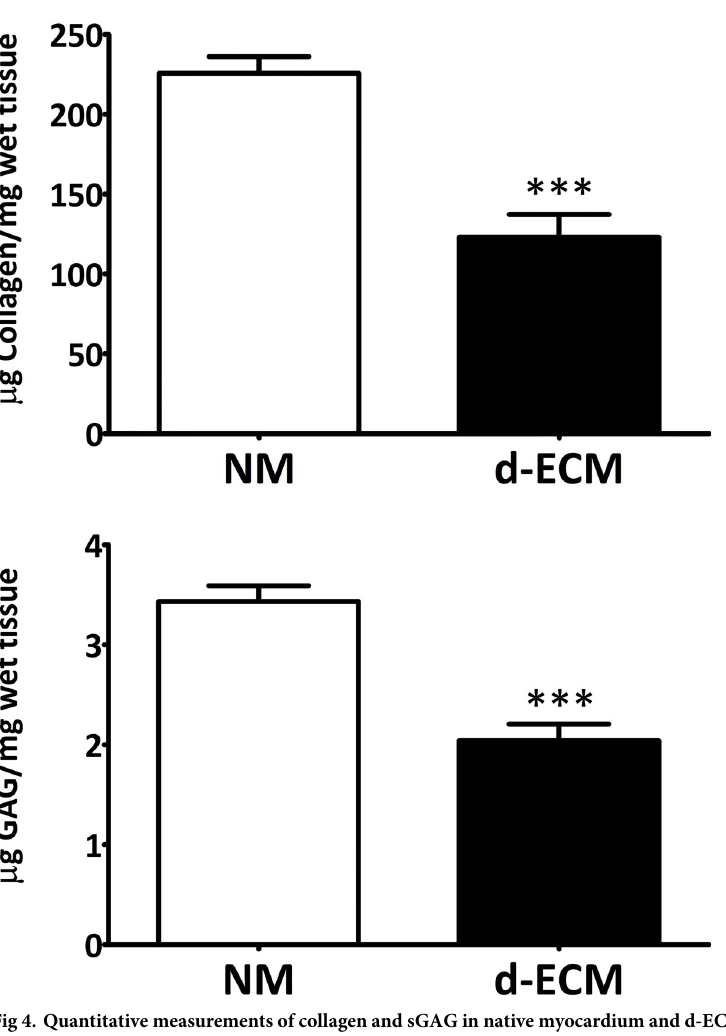
Fig 4. Quantitative measurements of collagen and sGAG in native myocardium and d-ECM. Data showing the retention of collagen (123.0 ± 14.33 μ g/mg wet tissue) and sGAG (2.039 ± 0.1681 μ g/mg wet tissue) in d-ECM compared with native myocardium (225.8 ± 10.41 μ g/mg wet tissue; 3.433 ± 0.1572 μ g/mg wet tissue). Each value expresses the mean of 10 samples (n = 10) ± SEM ( ��� p � 0.0001).